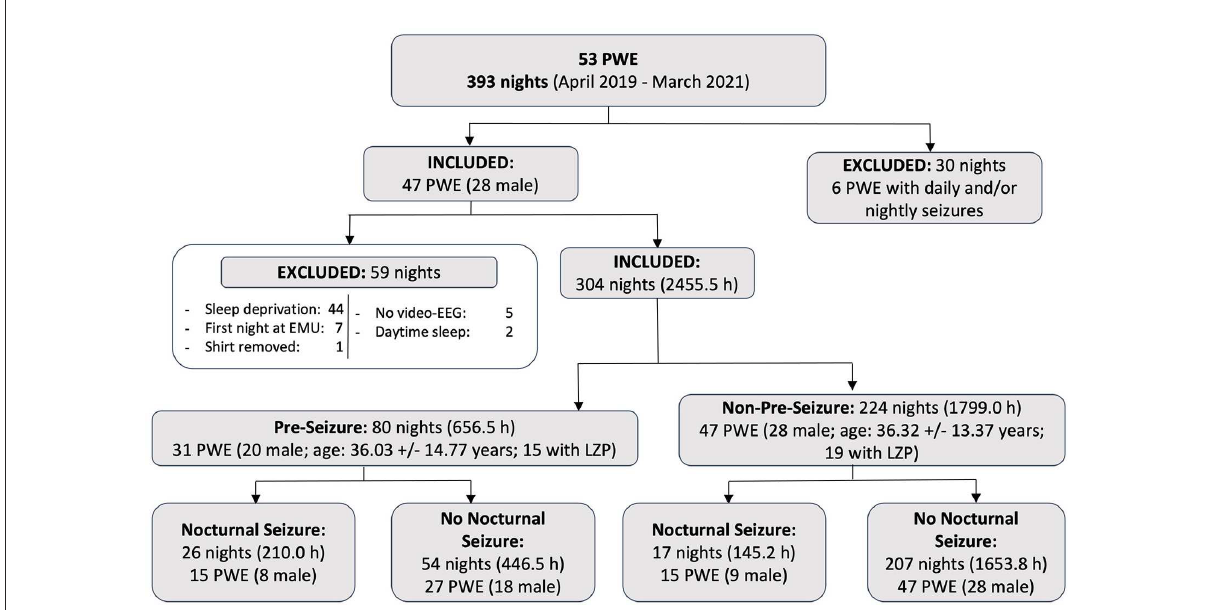
FIGURE3 Summary of data collected and included based on inclusion and exclusion criteria. A total of 393 nights of continuous recordings were acquired from 53 patients who were recruited at our Epilepsy Monitoring Unit between April 2019 and March 2021. Of these, 304 nights (2,455.5h) were included and analyzed in this study. PWE, people with epilepsy; LZP, patients who took lorazepam at least once during their hospitalization; Nocturnal Seizure, nights with at least one clinical nocturnal seizure during sleep; No Nocturnal Seizure, nights with no clinical seizure during